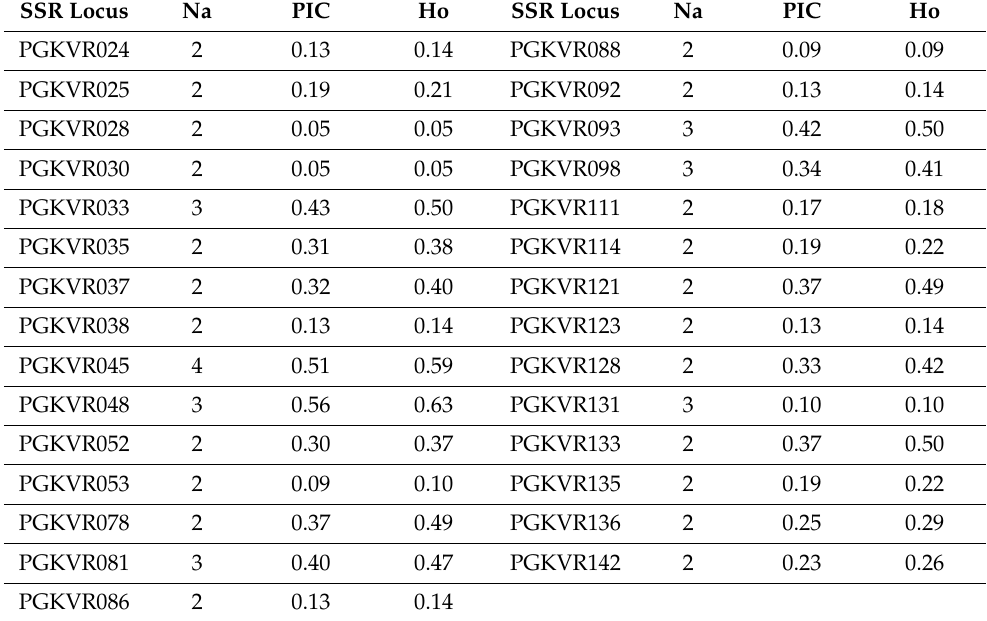
Table 5. Number of alleles (Na), polymorphic information content (PIC), and observed heterozygosity (Ho) at 29 polymorphic loci in pomegranate